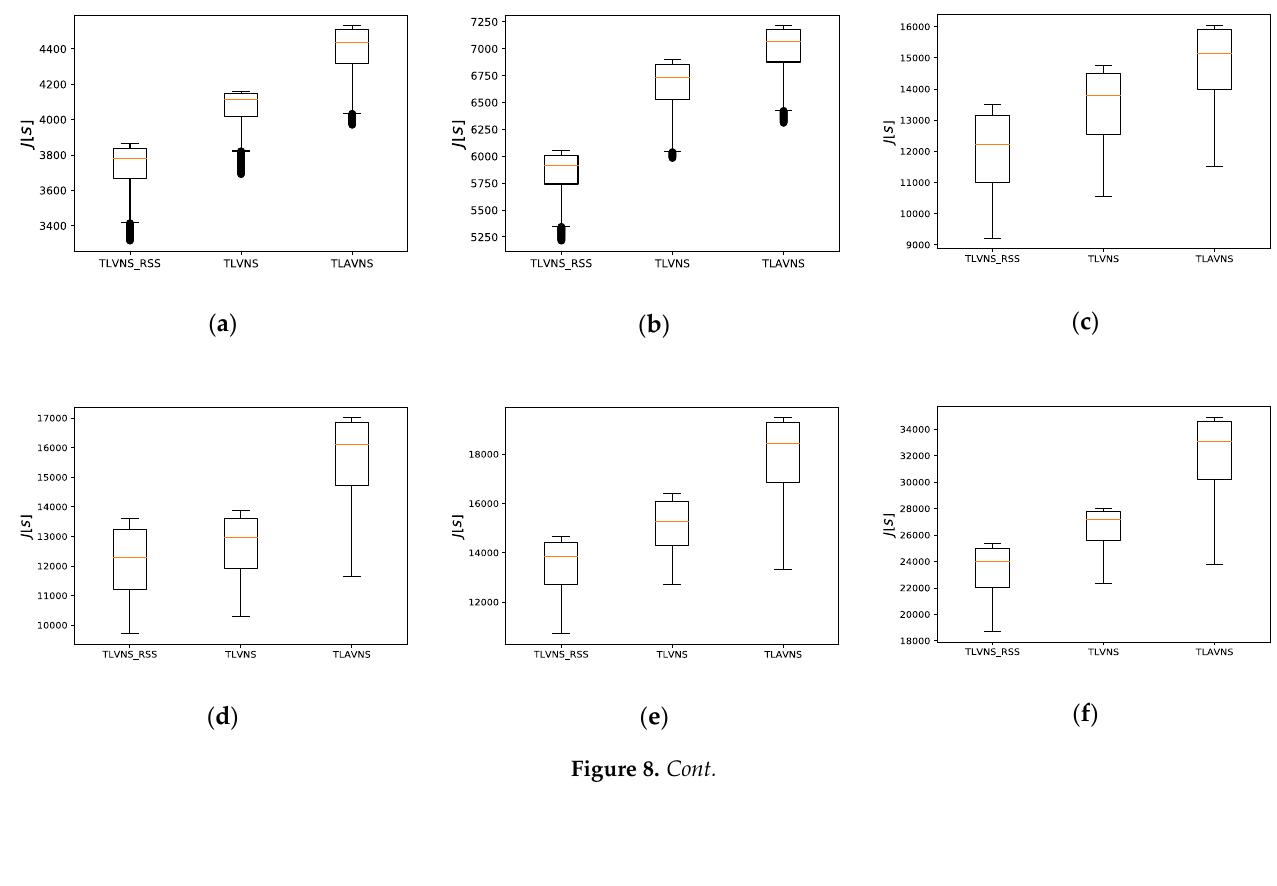
( i ) Figure 8. ( a – c ) The distribution of solutions for the small sized problem; ( d – f ) The distribution of solutions for the medium sized problem; ( g – i ) The distribution of solutions for the large sized problem. 6. Limitation Analysis The integrated sensor assignment and path planning model proposed in this paper may have some limitations in the real world applications. These limitations may lead to the failure of mission planning. The main application limitations are as follows: (1) Uncertain factors in the process of task execution may lead to the failure of the plan, such as wind interference, weather impact on the performance of the sensor, etc. (2) In order to simplify the complexity of the problem, we assume that UAVs fly at dif- ferent altitudes to avoid collision between UAVs. However, this may not meet the require- ments of some real-world tasks. 7. Conclusions